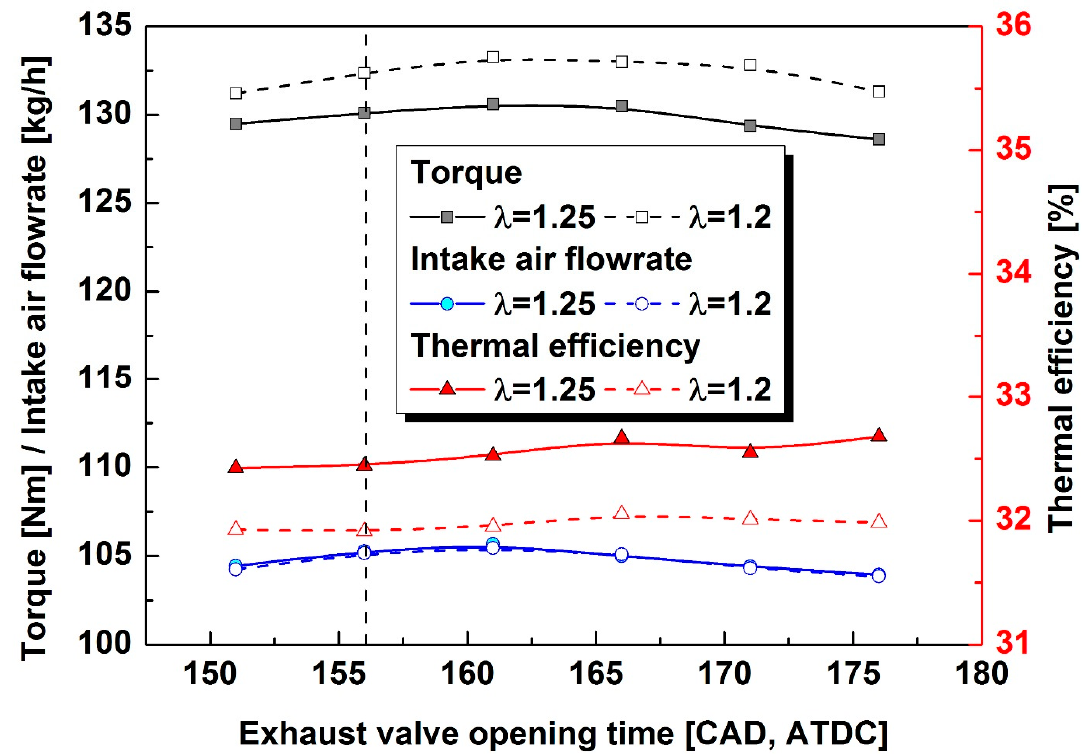
Figure 7. Torque, intake airflow rate, and thermal efficiency variations with exhaust valve open timing change at constant intake valve open timing of 327 CAD ATDC and excess air ratios of 1.25 and 1.20.